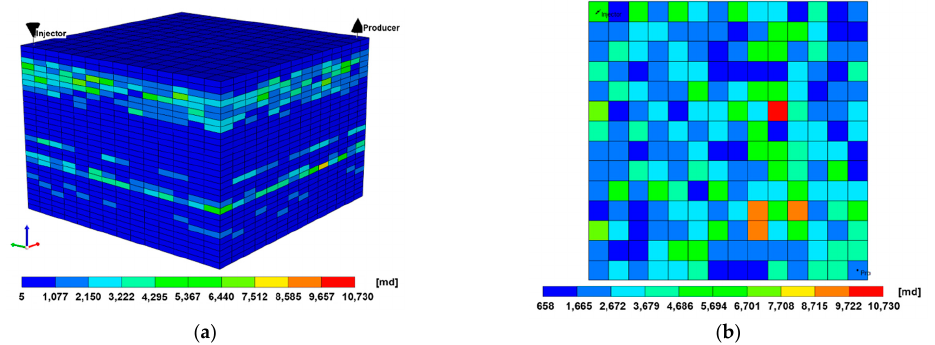
Figure 8. ( a ) 3D reservoir model and ( b ) areal heterogeneity of the fourth layer.